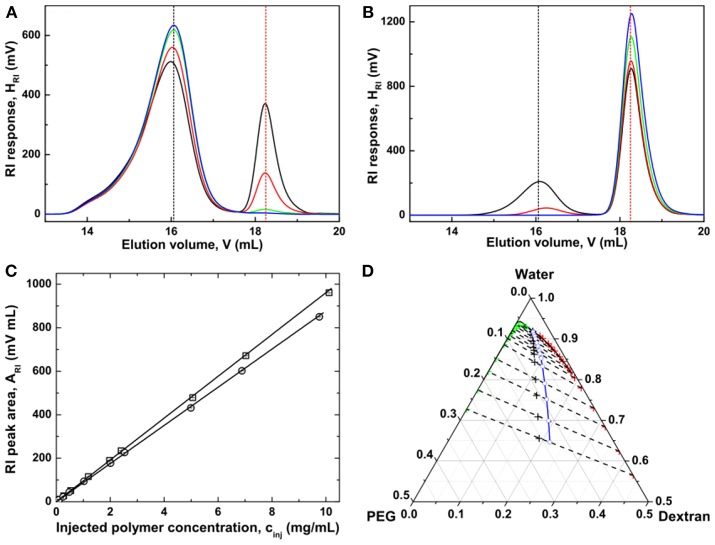
GPC chromatograms of coexisting dextran-rich (A) and PEG-rich phases (B) at ε = 0.030 (black), 0.200 (red), 0.982 (green), and 2.087 (blue). The peak retention volumes of the native dextran and PEG are 16.06 mL (black dashed line) and 18.25 mL (red dashed line), respectively. (C) Dependence of the RI peak area ARI on polymer concentration cinj of the solutions injected into the size-exclusion chromatography columns for dextran (squares) and PEG (circles). (D) The resulting phase diagram of the PEG–dextran–water system. In the phase diagram, the cloud point curve is shown as a solid curve. The compositions of the initial solutions for which size-exclusion chromatography measurements after phase separation were performed are indicated by black crosses. The end points of the respective tie lines (dashed lines) consist of red crosses indicating the compositions of the dextran-rich phases and green crosses indicating the compositions of the PEG-rich phases. The midpoints (blue circles) of the tie lines were extrapolated to the binodal to determine the critical point. Adapted with permission from Zhao et al. (2016b). Copyright (2016) Chem. J. Chinese Universities.